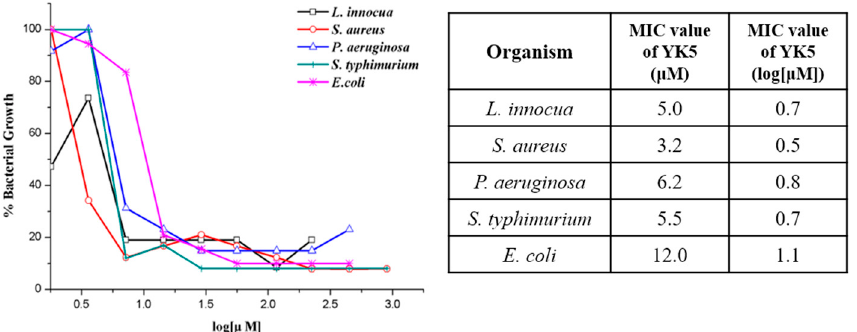
) Staphylococcus (cid:35)